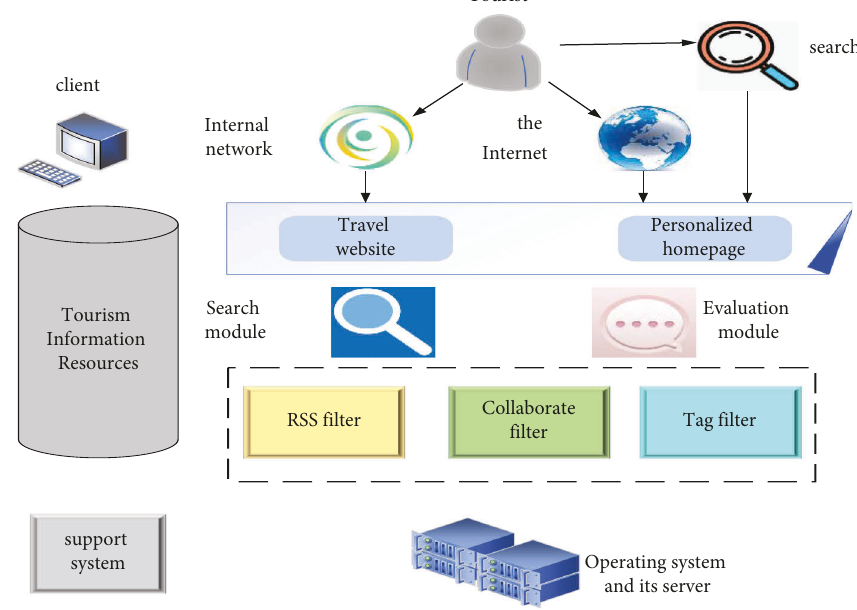
Figure 3: Tourist information resource management platform based on machine